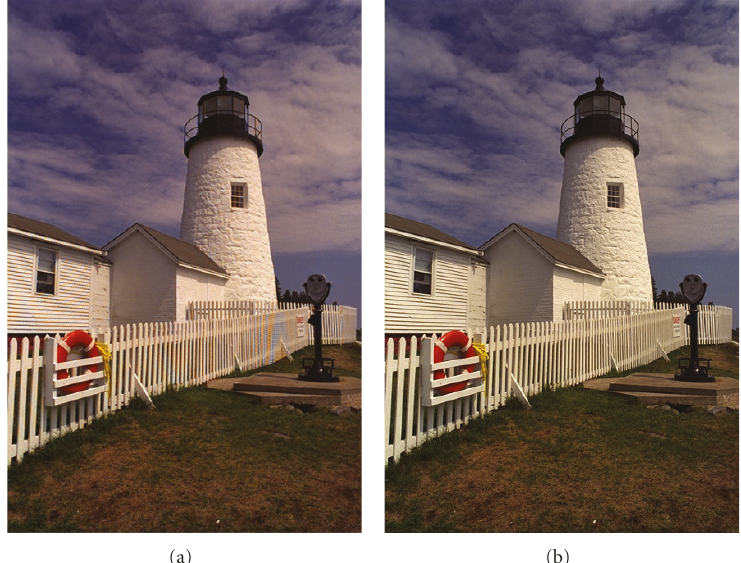
Figure 3: An example of the e ff ects of demosaicing artifacts on the AWB method: (a) AWB result of color demosaicing method [7] and (b) AWB result of original image.